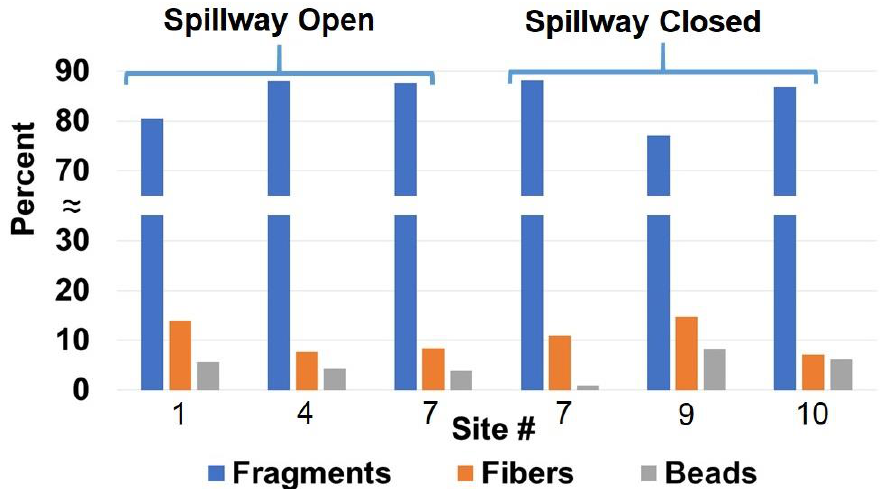
Figure 3. Morphologies of microplastics in water from select sites in the Mississippi Sound. Site number information is given in Table 1.